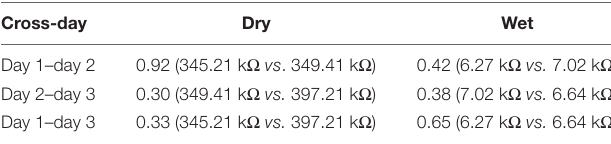
TABLE 2 | The statistical significance of p -value in the impedance comparison of